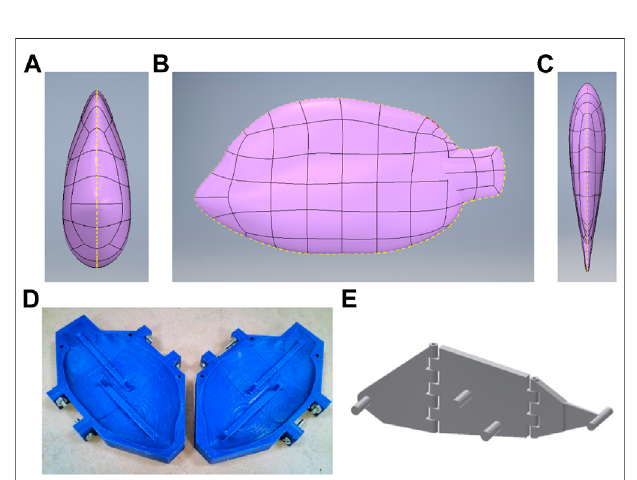
FIGURE3| Softrobotic fi shdesigncomponents. (A – C) Illustrationofthe robotic fi sh CAD design, from left toright: front, sideand topviews(Rajendran and Zhang, 2018); (D) 3D-printed fi sh molds (Rajendran and Zhang, 2018); (E) 3-link hinged attachment.